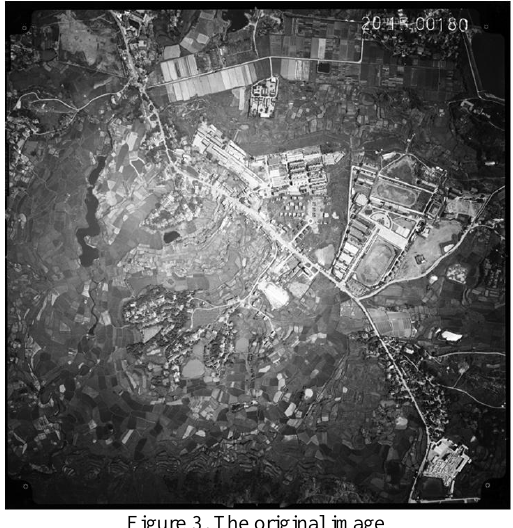
Figure 3. The original image